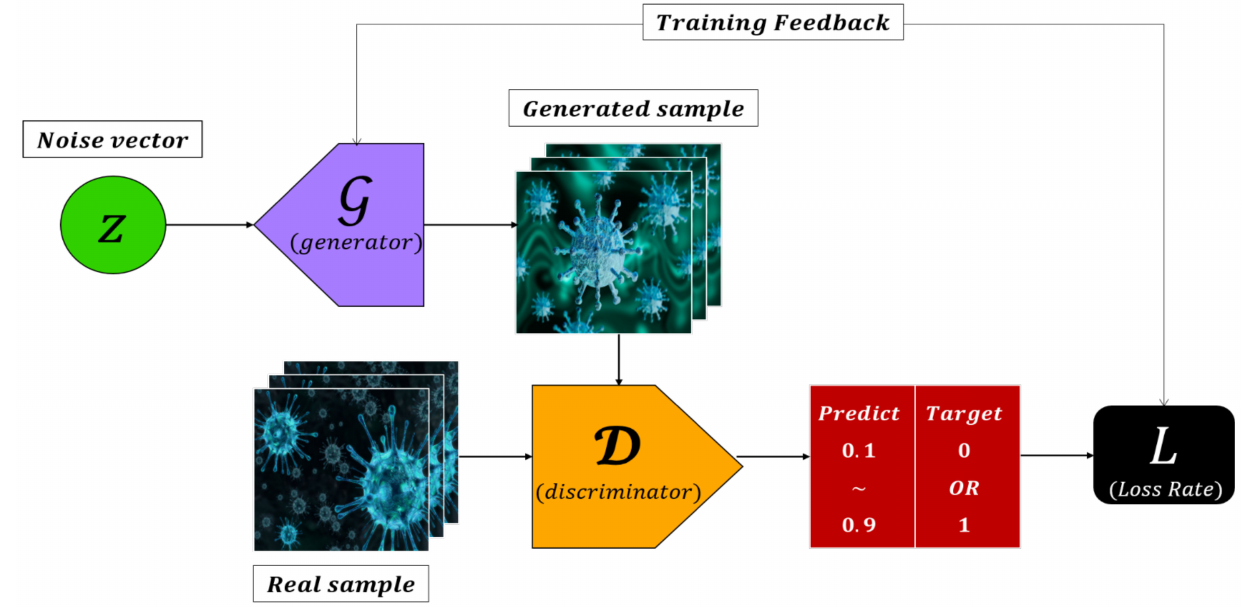
Figure 1. Training algorithm of GAN (Generative Adversarial